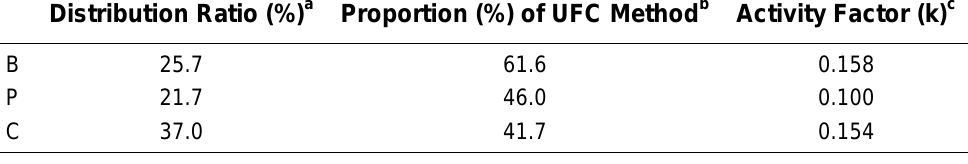
Market Share Ratios for Meat Type with the Corresponding Activity Factors Distribution Ratio (%)